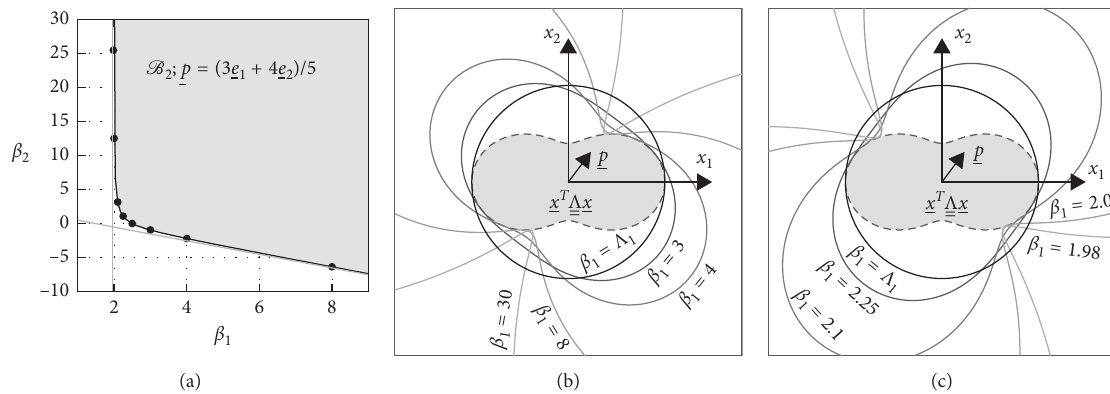
Figure 5: (a) Parameter region B for the marked black points of (a) for Λ